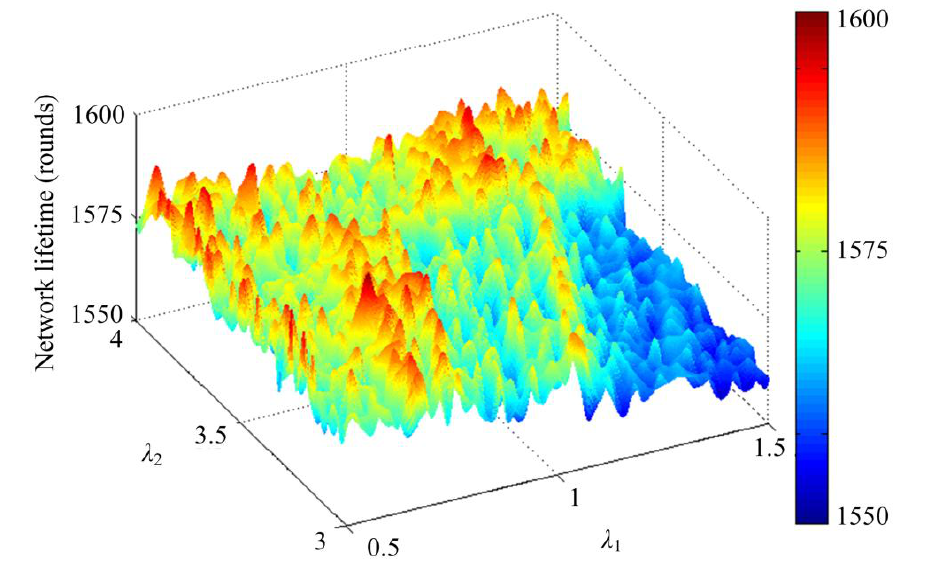
Figure 7. Plot of network lifetime with 100% sensing coverage versus λ τ = 1 and τ = 1 2